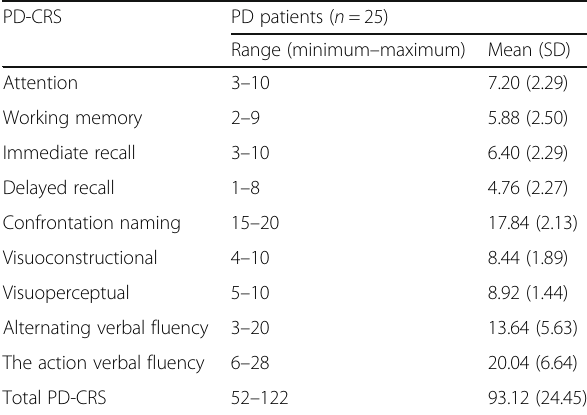
Table 3 CRS-PD score for PD